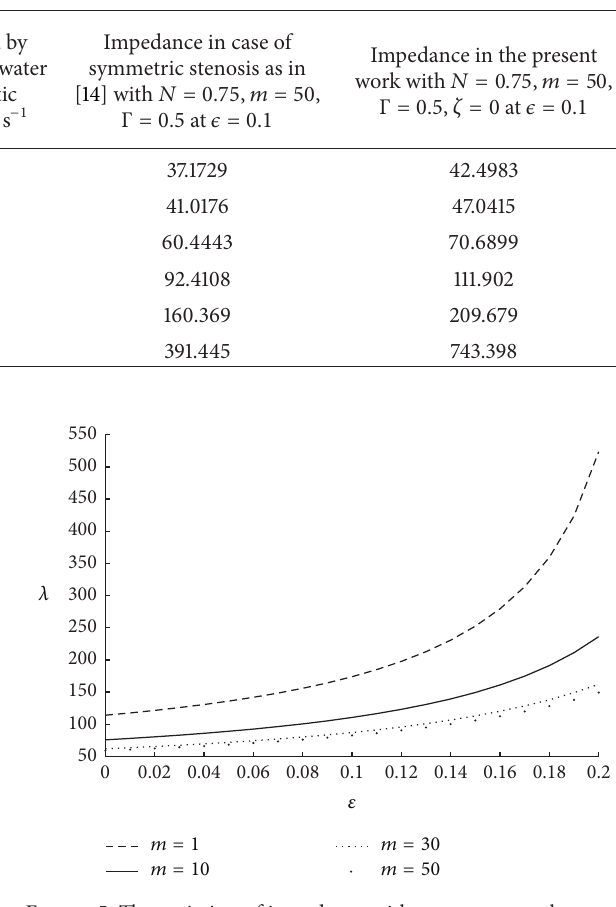
Figure 5: The variation of impedance with respect to 𝑚 when 𝑟 𝑐 = 0.1 , 𝑁 = 0.75 , Γ = 0.5 , 𝑢 = 0.01 , and 𝜙 = −0.05